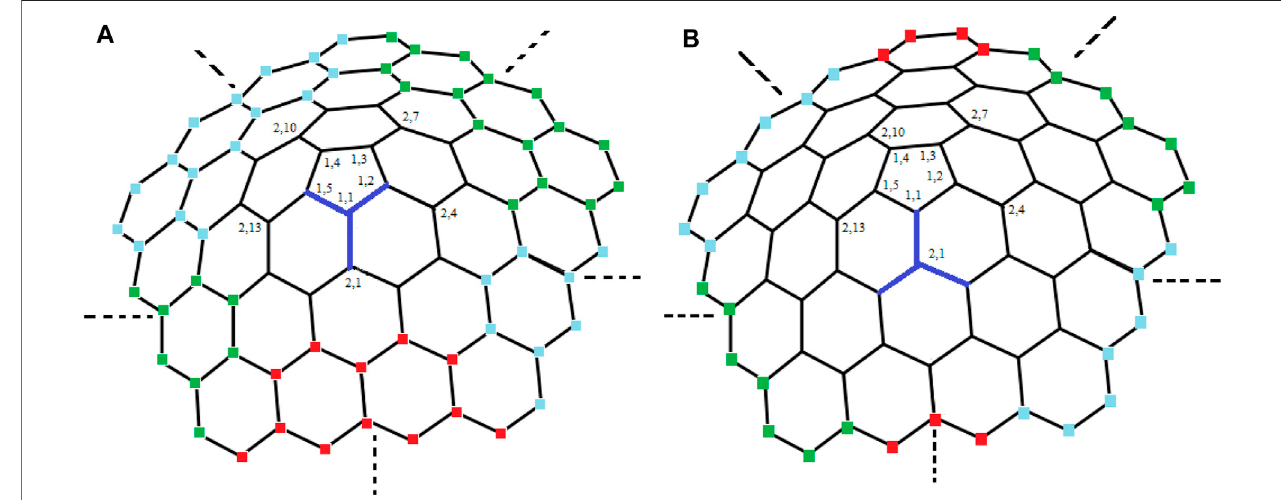
FIGURE 5 | CNC 5 [m] for Case 3 (Subcase 1 (Panel A) and 2 (Panel B) ).